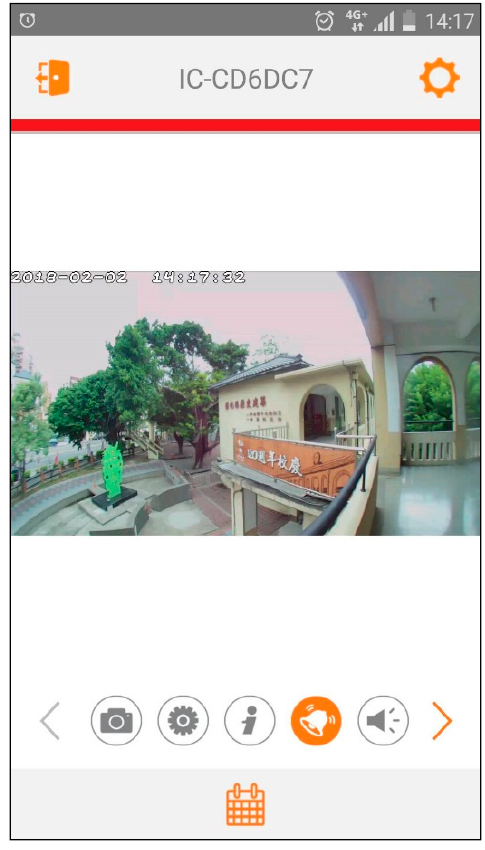
Figure 6. Monitoring interface on mobile devices (warnings and notifications). Arts 2018 , 7 , x FOR PEER REVIEW